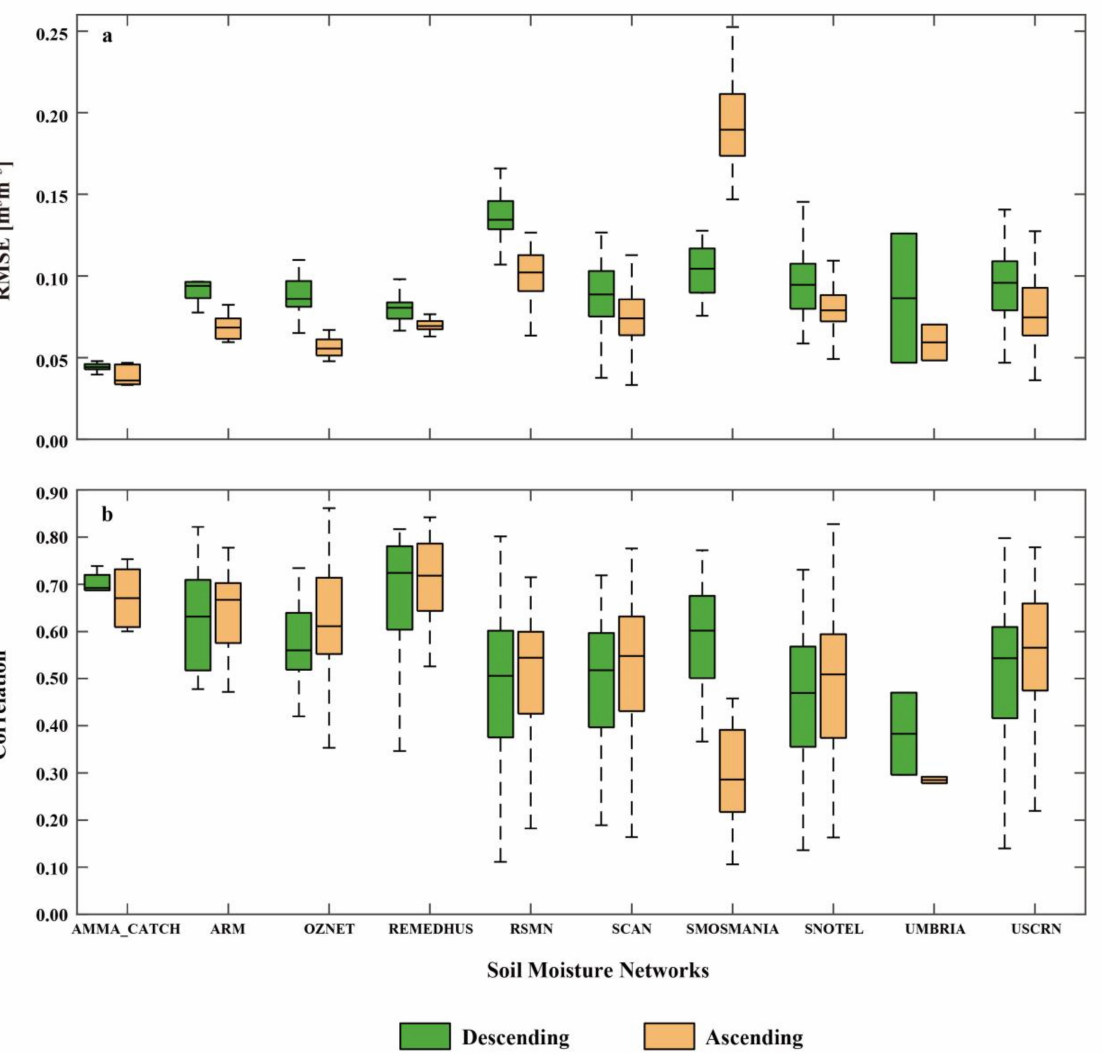
Figure 5. Comparing the calibrated FY-3C SM with the International Soil Moisture Network (ISMN) datasets, depicting ( a ) RMSE (unit: m 3 m − 3 ) and ( b ) correlation coefficients. The green boxes represent descending data, and the yellow boxes represent ascending